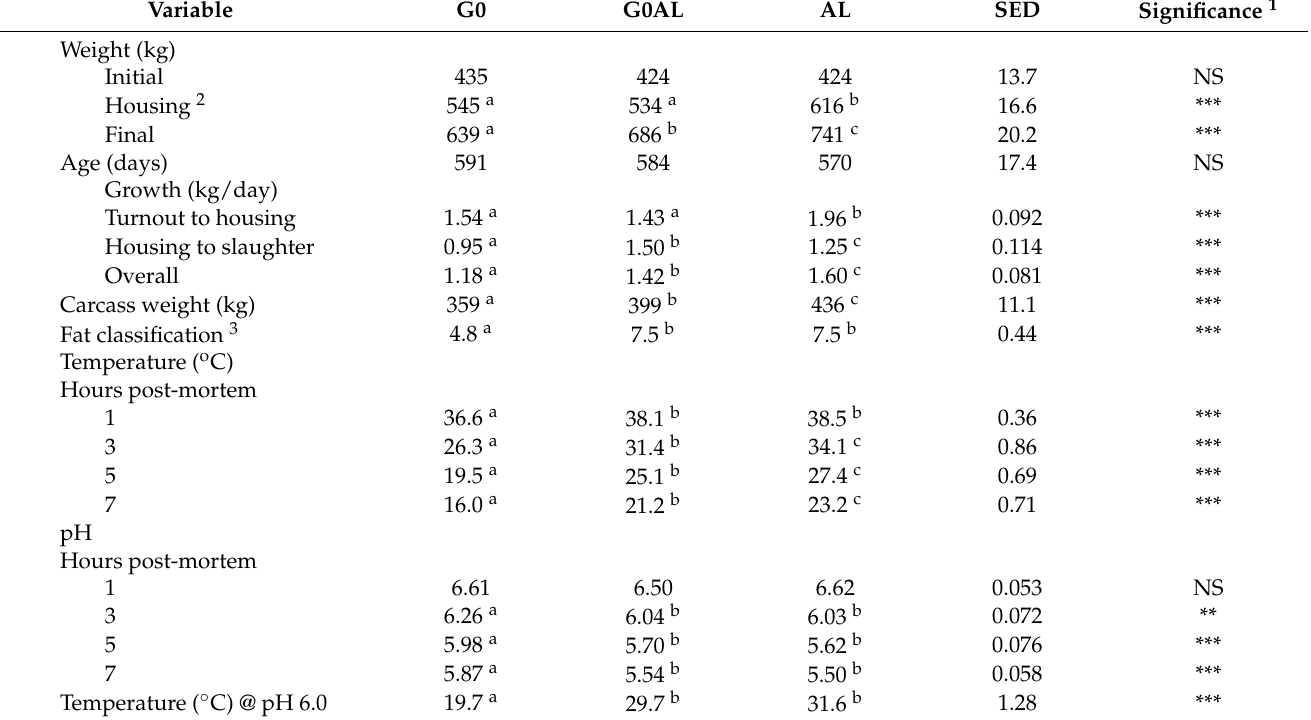
Table 1. Growth, carcass characteristics, longissimus muscle pH and temperature decline post- mortem of suckler bulls slaughtered after: 199 days at pasture (G0); 98 days at pasture followed by 101 days indoors and offered concentrates (G0AL); and 199 days indoors and offered concentrates (AL).